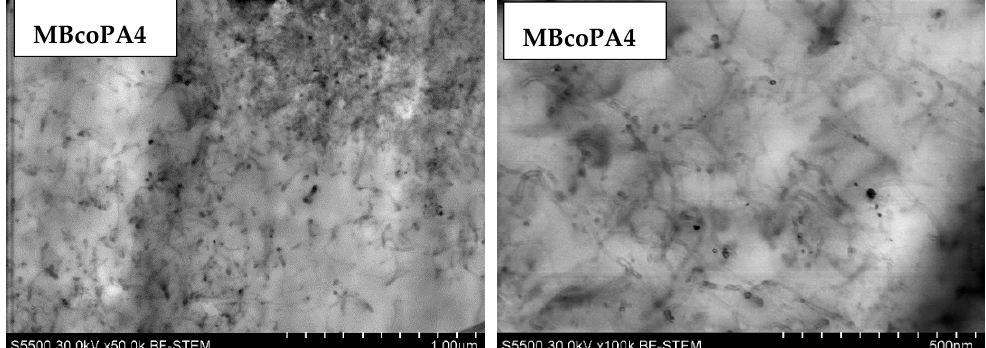
Figure 2. HR-STEM images of the microstructure of the copolyamide masterbatches containing 7 wt % MWCNT.